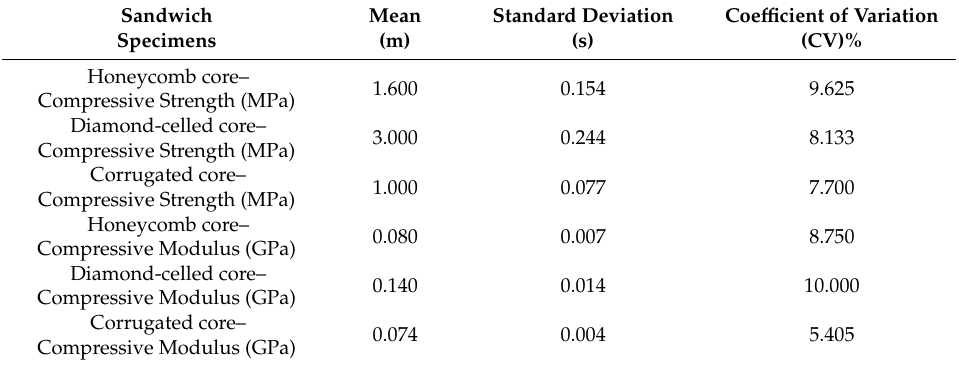
Table 5. Statistical parameters determined from the compressive test of sandwich specimens.